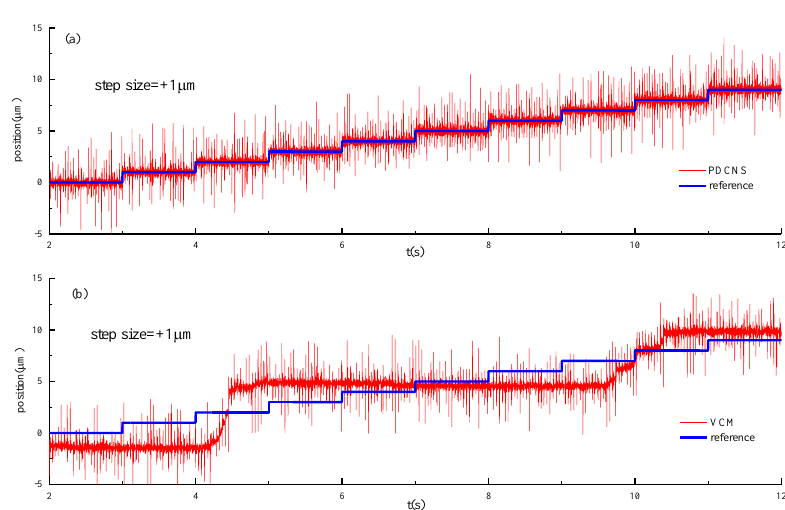
Figure 14. Multistep (step size of +1 μm) response of ( a ) PDCNS and ( b ) VCM.